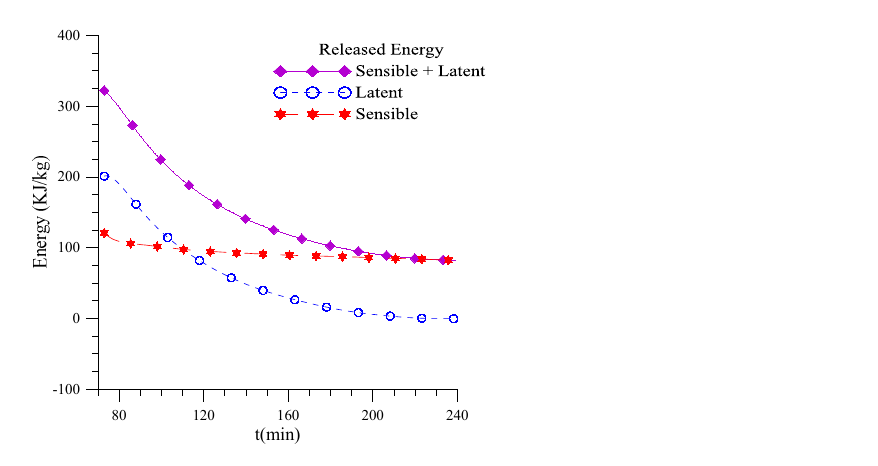
Figure 30. Latent and sensible thermal energy released by the PCM during the solidification process.